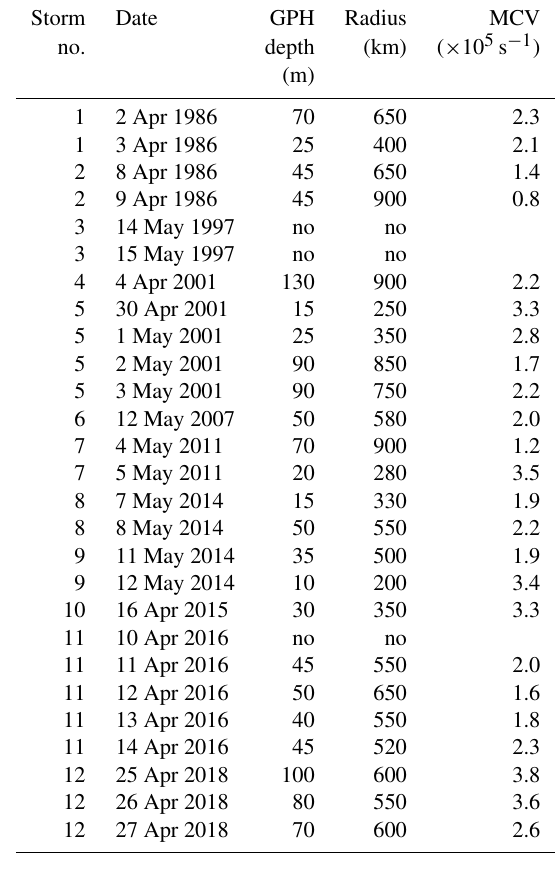
Table 1. Depth, radius and the measure of curvature vorticity (MCV) of the 500hPa cyclones for the 27d, in which the highest surface runoff was observed over the study area in the late spring during the period 1986–2018 (the reference storms). Note that in 24 of the days an upper-level cyclone was